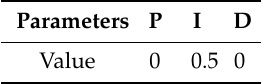
Table 4. Parameters used for step